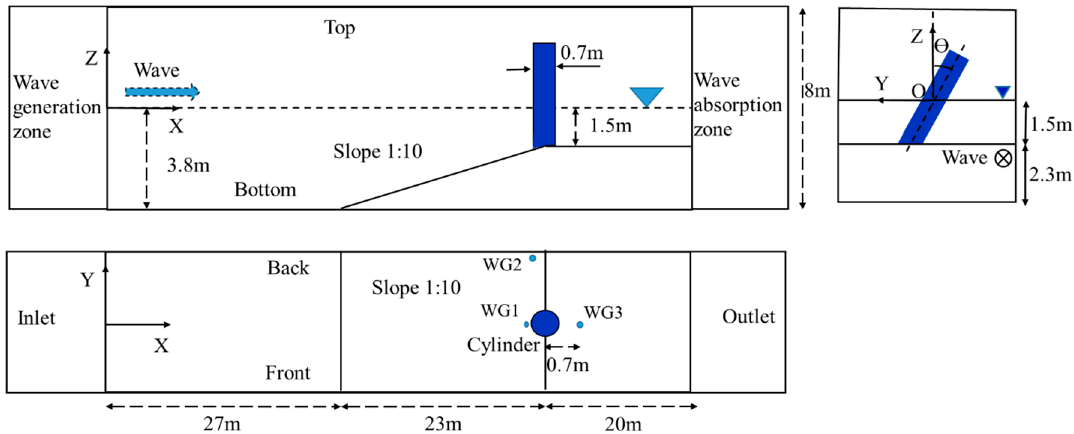
Figure 1. The layout of the numerical wave tank: front view (top); side view (right); plan view (bottom).